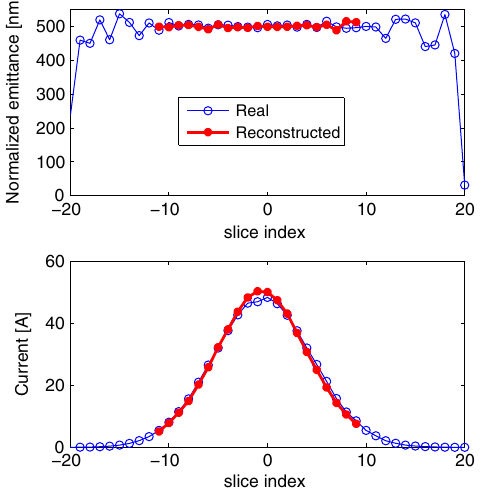
FIG. 6. Simulation of a horizontal slice-emittance measure- ment. The upper and lower plots show the normalized slice emittance and the current profile, respectively. The blue curves with open points correspond to the real simulated values, the red curves with full points to the reconstructed